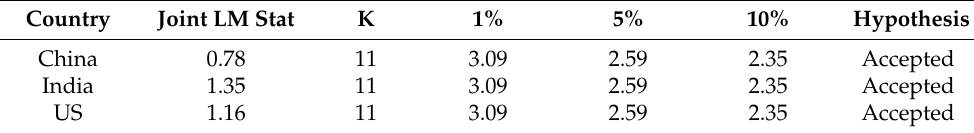
Table A1. Canova–Hansen Seasonal Unit Root